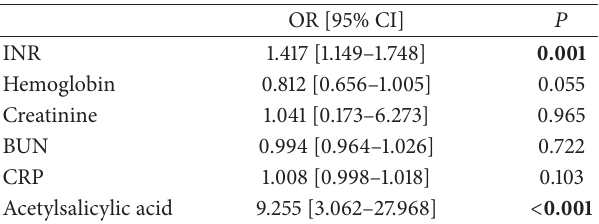
Table 3: Odds ratios (ORs), 95% confidence intervals (CIs), and 𝑃 values when comparing laboratory values and acetylsalicylic acid use between patients using warfarin with bleeding-related (SG) and non-bleeding-related (CG) reasons for their emergency department